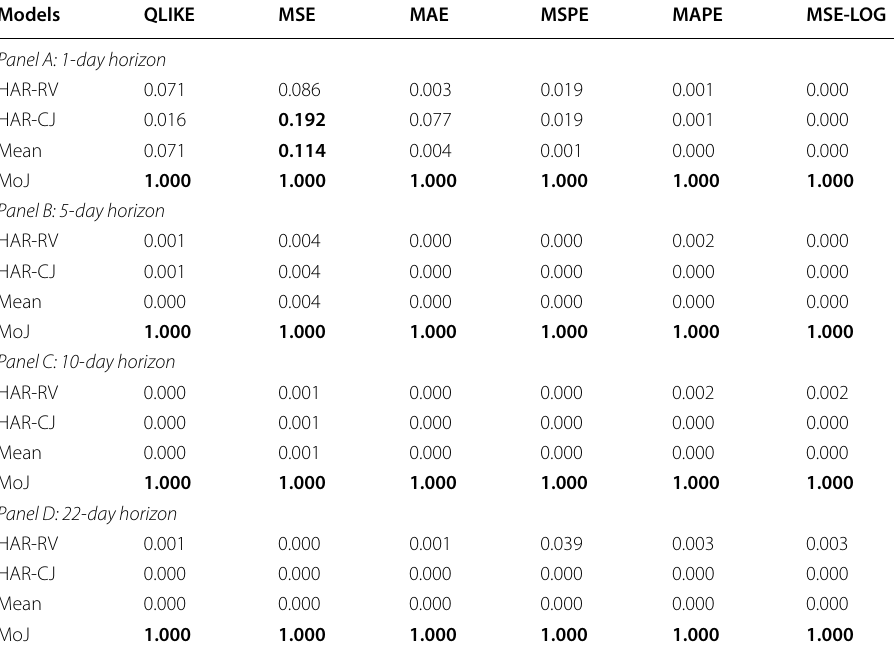
Table 6 MCS out-of-sample forecasting test based on various look-back